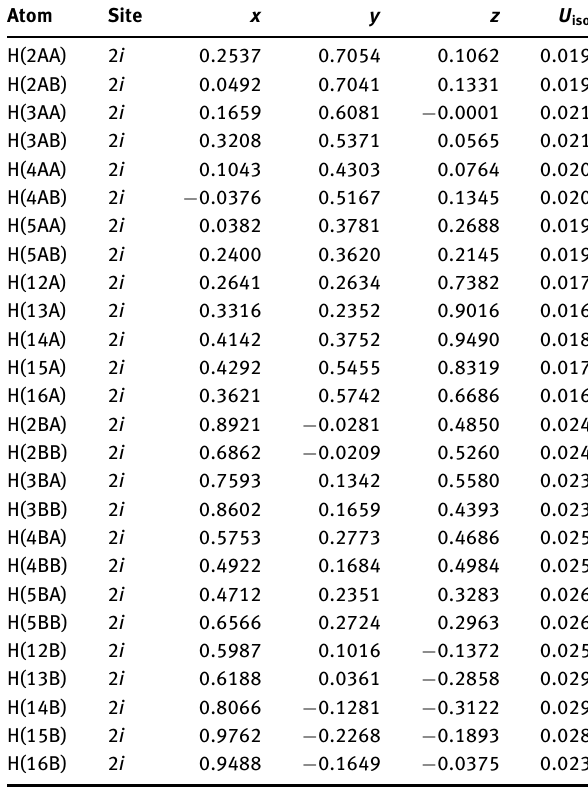
Table 2: Fractional atomic coordinates and isotropic or equivalent isotropic displacement parameters (Å 2